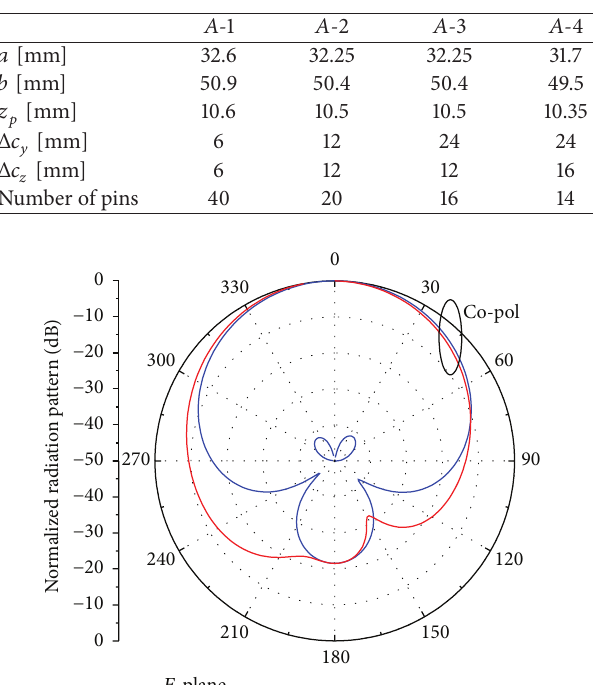
Table 3: SIW antenna dimensions.